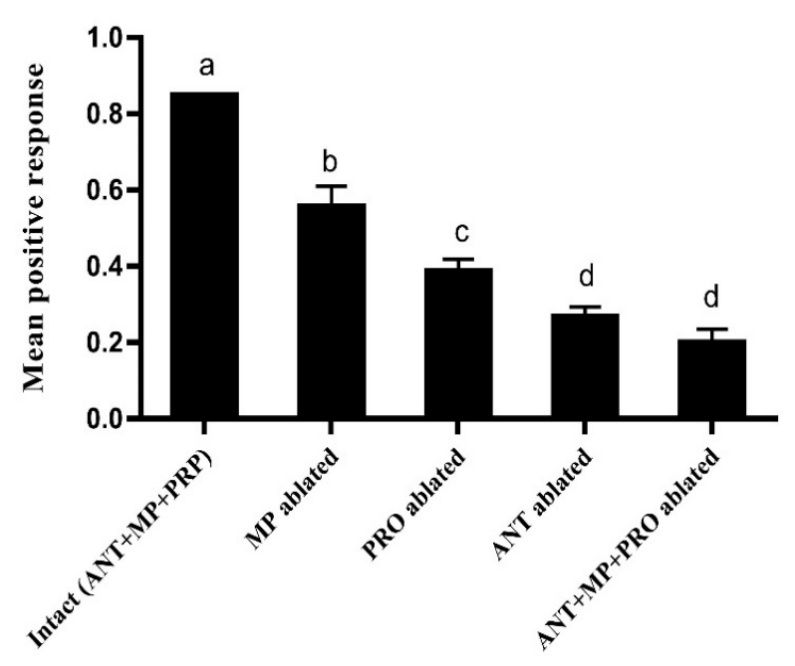
Figure 3. The effect of olfactory organs on the response of B. dorsalis males to ME. Assays were performed in trap cages (30 × 30 × 30 cm 3 ) after the removal of the antennae (ANT), maxillary palps (MP) and proboscis (PRO) in a mixture of 100 µ L ME and 900 µ L MO, or 1 mL of MO alone (a control). No flies were trapped in the control MO cages. Data are presented as the mean ± SE. Different letters on the histogram bars indicate significant differences based on one-way ANOVA followed by Tukey’s HSD multiple comparison test ( p < 0.05).